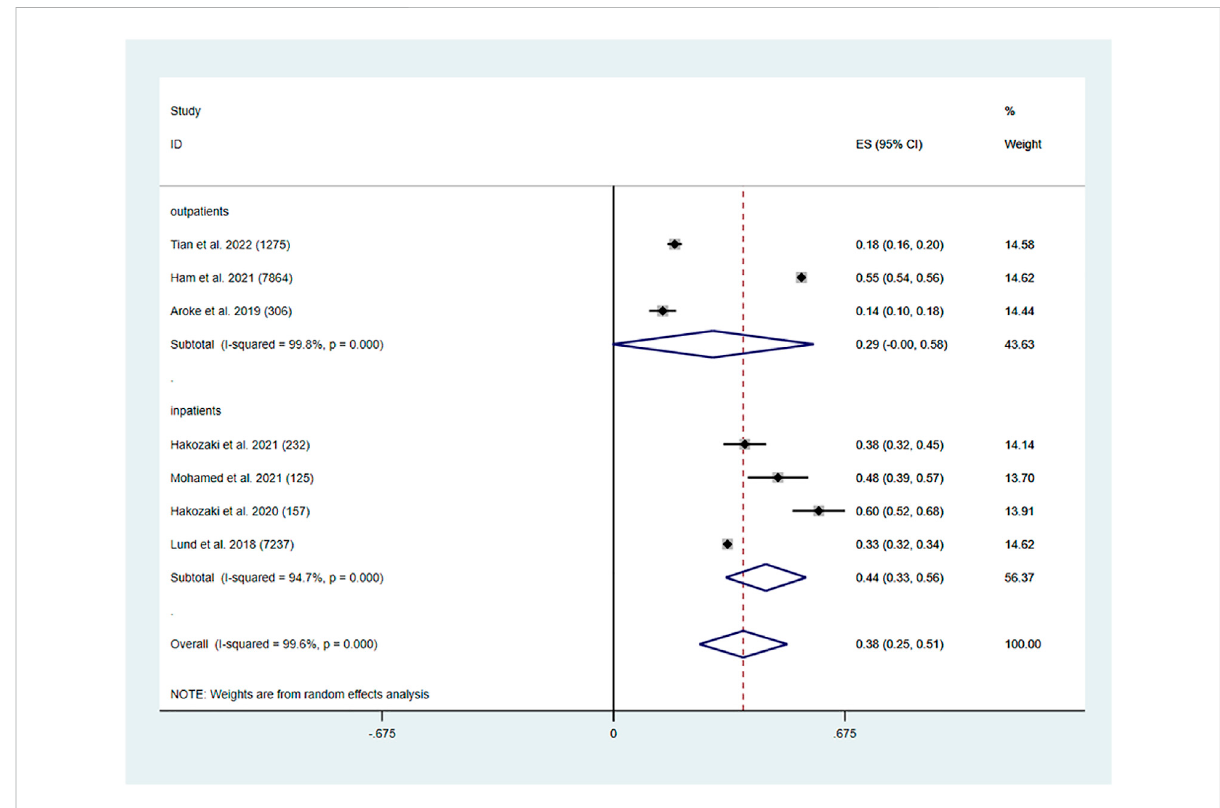
FIGURE 2 Prevalence of polypharmacy in the older lung cancer